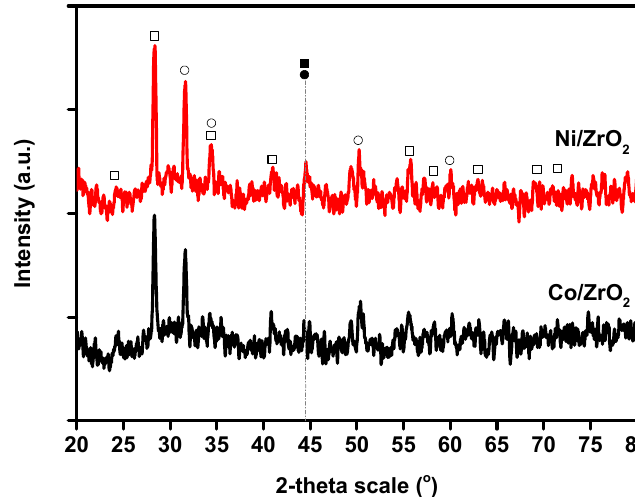
Figure 2. XRD pattern for Ni/ZrO 2 and Co/ZrO 2 catalysts after reduction at 600 °C; ( ● ) peaks correspond to metallic Ni, ( ■ ) peaks correspond to metallic Co, ( □ ) peaks correspond to monoclinic phase of ZrO 2 (m-ZrO 2 ) and ( ○ ) peaks correspond to tetragonal phase of ZrO 2 (t-ZrO 2 ).